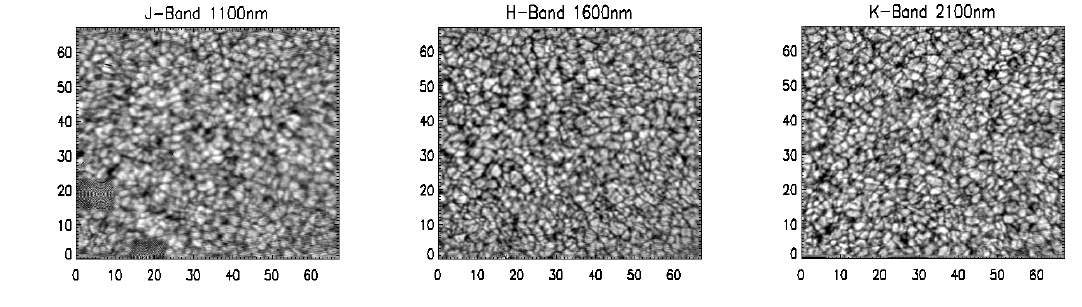
Figure 22: Images of solar granulation in the infrared J, H, K bands. In each case a sequence of short exposure images was processed using the Multi-Object Multi-Frame Blind Deconvolution ( Momfbd ) reconstruction algorithm. In some images artifacts from the reconstruction are visible. The images are not from the same regions of the Sun and are taken at different times under different seeing conditions. The axes are marked in units of arcseconds. Comparison of the contrasts at these wavelengths shows larger than expected contrast in the K-band images. Image reproduced with permission from Penn (2008), copyright by AGU.